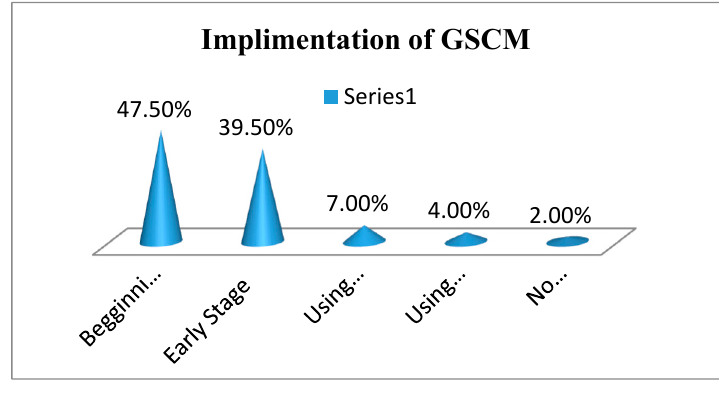
Figure 8. Implementation of GSCM.